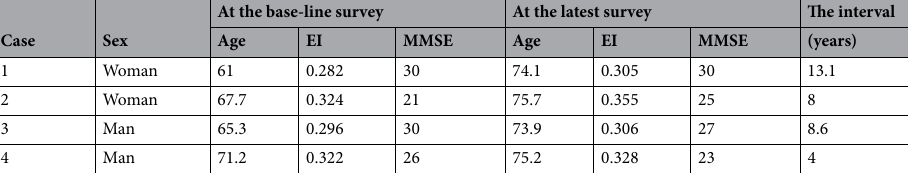
Table 4. The development of DESH in the participants who underwent the follow-up MRI (n = 669). EI Evans index, DESH disproportionately enlarged subarachnoid space hydrocephalus (EI > 0.3), MMSE Mini-Mental State